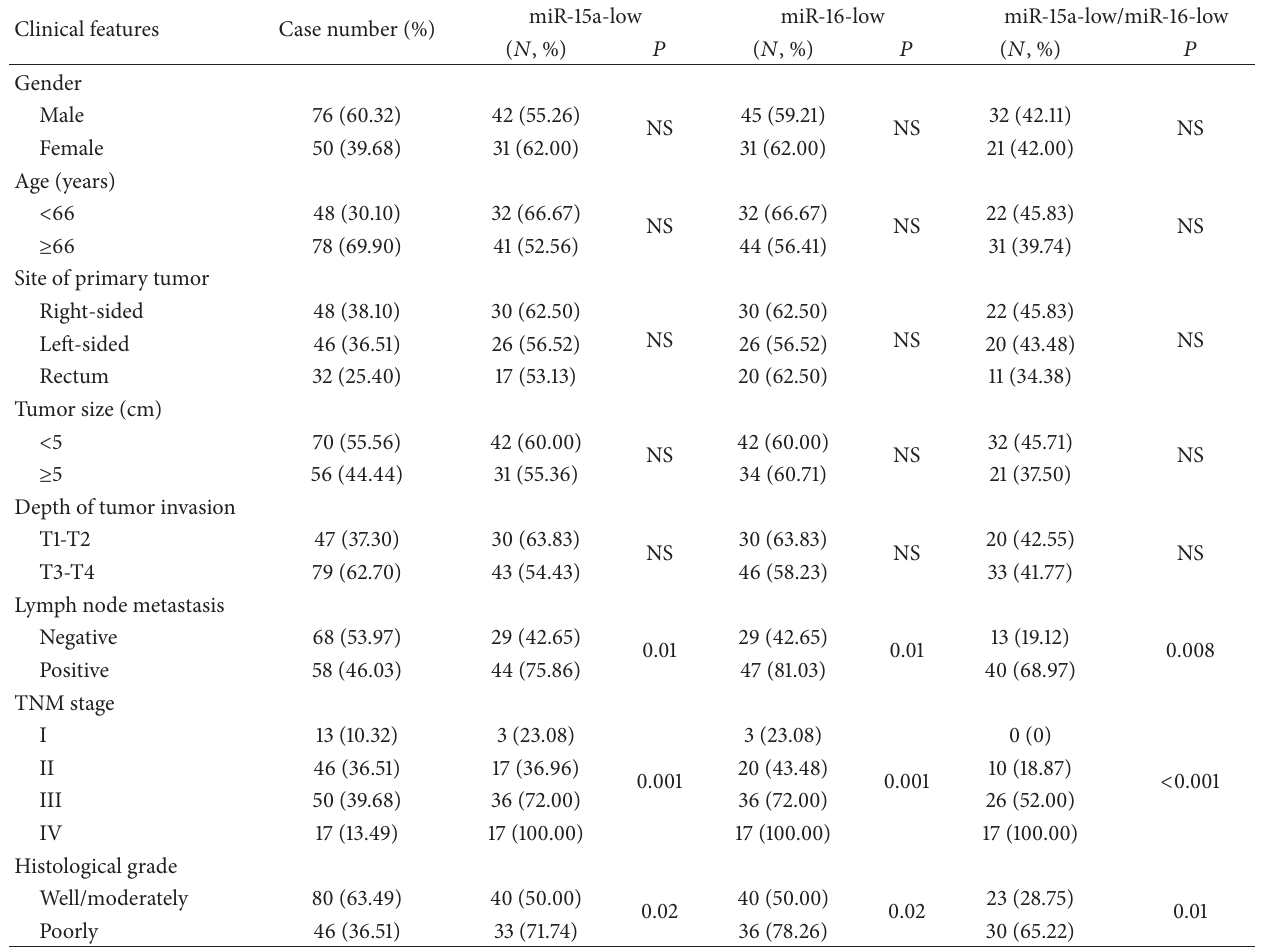
Table 1: Associations of miR-15a and/or miR-16 expression with the clinicopathological characteristics of colorectal cancer. Clinical